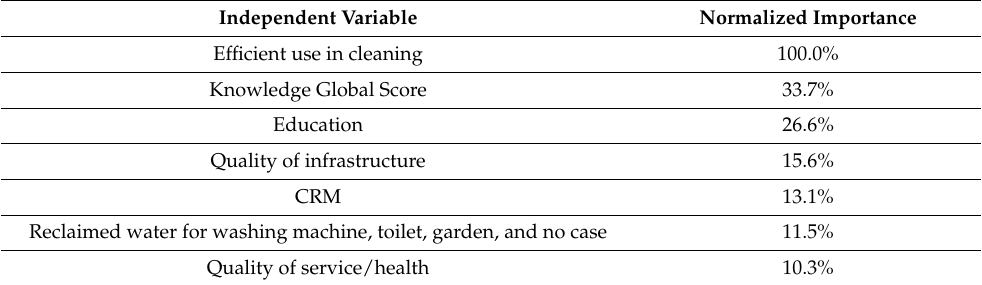
Table 3. Importance of the independent variable of education, professional occupation, knowl- edge, values/needs, and attitudes together to predict the range of household consumption. (Source: Authors). Independent